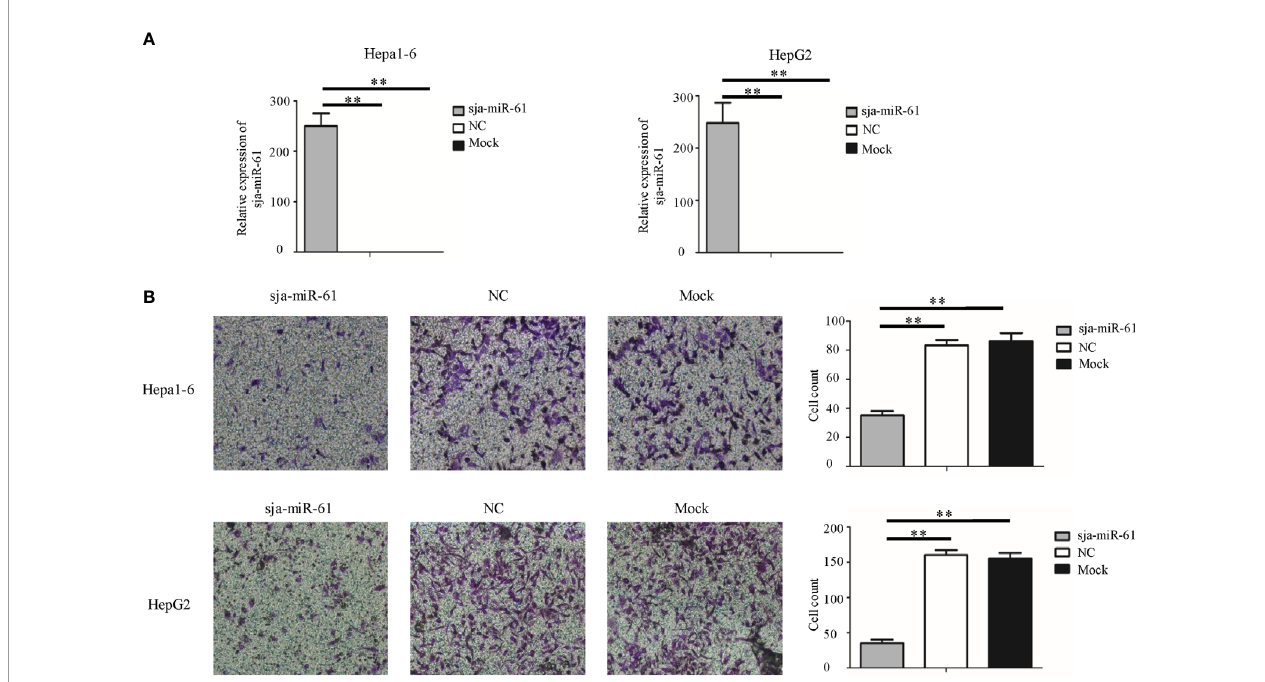
FIGURE 1 | Sja-miR-61-mediated inhibition of migration of hepatoma cells in vitro . Hepa1-6 and HepG2 cells were transfected with sja-miR-61 mimics and NC (negative control). mimics, respectively, and 48 h later, the sja-miR-61 was detected by qRT-PCR (A) . Cell migration was evaluated using transwell inserts without matrigel coating (B) . Data are presented as the mean ± SD, n = 3, ** p <